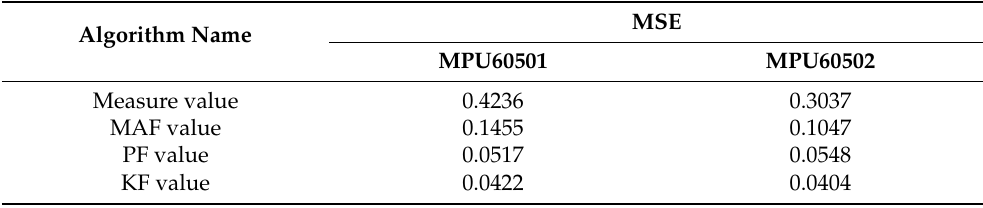
Table 1. Algorithm simulation of MSE.